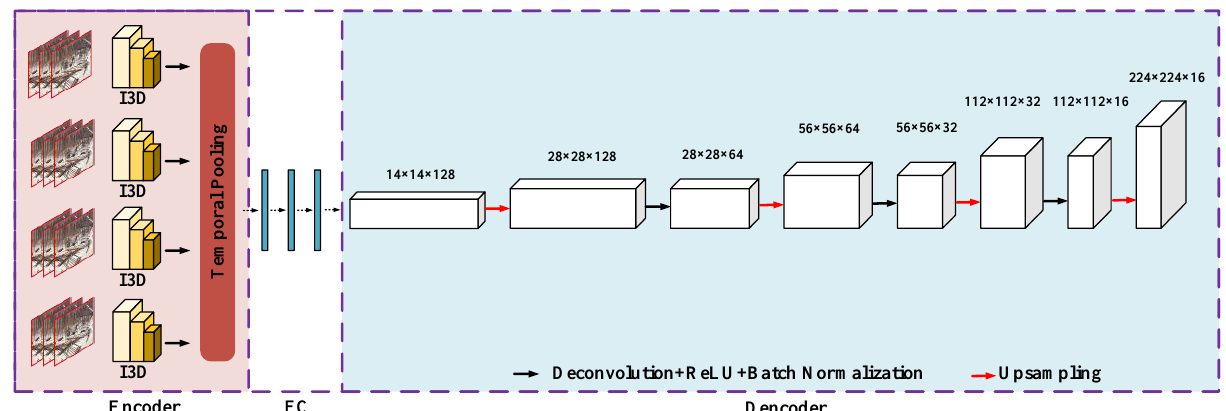
Figure 2. Structure chart of our I3D-AE.